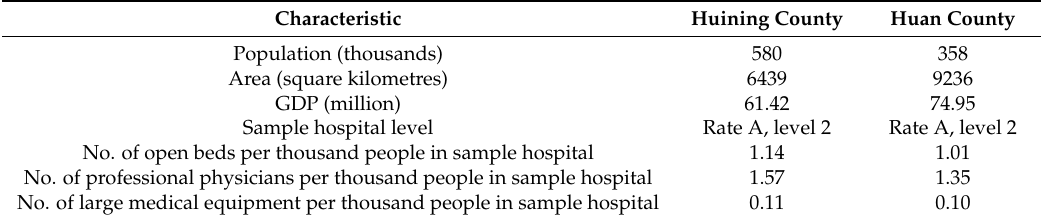
Table 1. Basic characteristics of the two counties and the medical capacity of two sample hospitals.